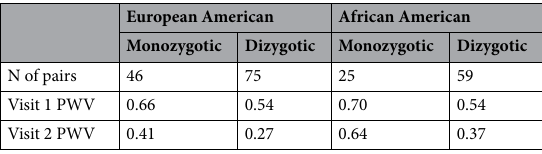
Table 2. Twin correlations of visit 1 and visit 2 by ethnicity and zygosity.